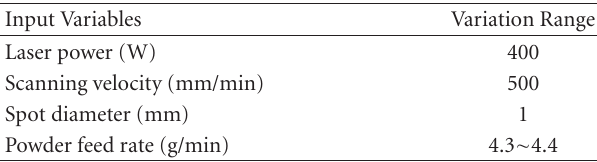
Table 2: The Laser Processing Parameters.